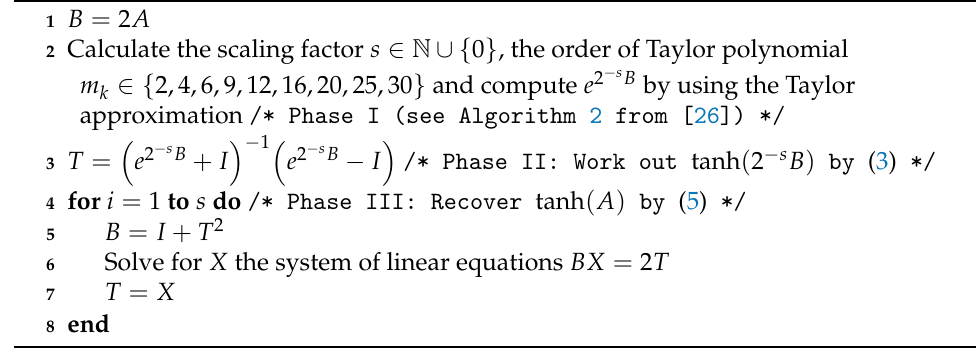
Algorithm 2: Given a matrix A ∈ C n × n , this algorithm computes T